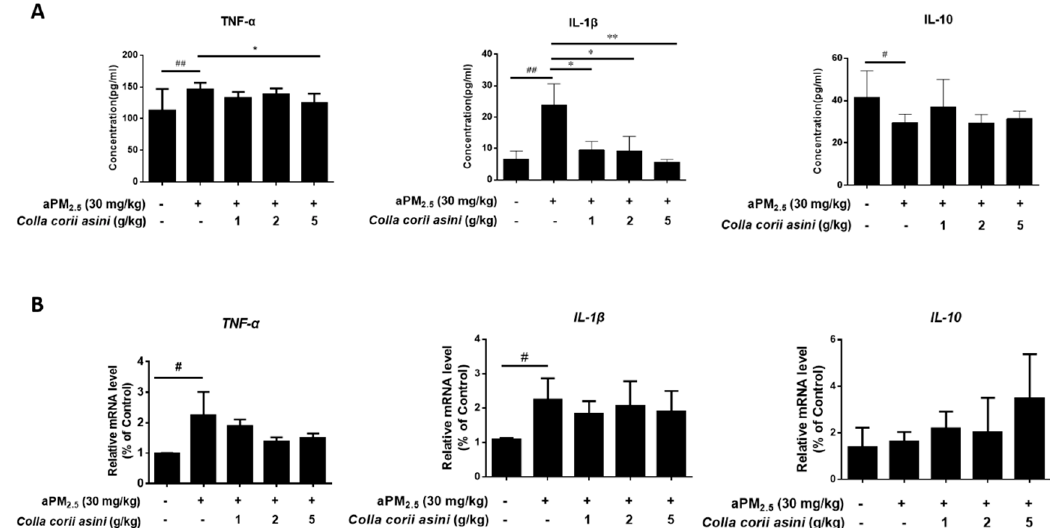
Figure 3. Colla corii asini prevented aPM 2.5 -induced inflammation. Effect of Colla corii asini on ( A ). TNF- α , IL-1 β , IL-10 concentrations (pg/mL) in BALF (mean ± SD, n = 8) and ( B ). relative gene expression of TNF- α , IL-1 β and IL-10 in the lungs of rats subjected to intratracheal instillation of aPM 2.5 for 11 weeks. Values are reported using the 2 −ΔΔ C t method and were obtained by comparison to those of the control group and normalized to β -actin (ACTB) (mean ± SD, n = 3). # p < 0.05 and ## p < 0.01, versus the control group; * p < 0.05 and ** p < 0.01, versus the aPM 2.5 group.